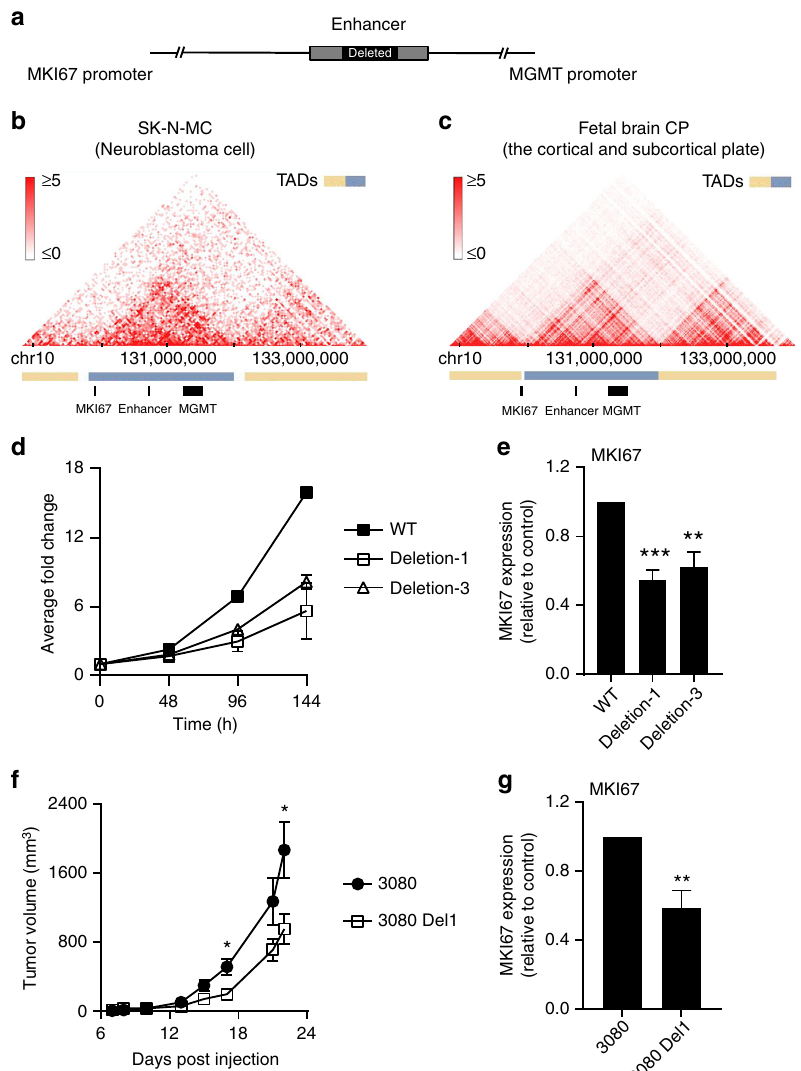
Fig. 6 Deletion of the K-M enhancer affects cell proliferation and Ki67 expression. a Schematic diagram showing the relative genomic location of MKI67 gene, the K-M enhancer, and MGMT gene. b , c The Hi-C analysis from SK-N-MC cells ( b ) and human fetal brain cortical plate ( c ) are taken from the 3D genome browser site 38 . The boundaries of the topologically associated domains (TADs) and the location of MGMT , MKI67 , and the K-M enhancer is indicated below. d Cell proliferation rate was analyzed by Incucyte. The cell con fl uency read out for each cell was normalized by the cell con fl